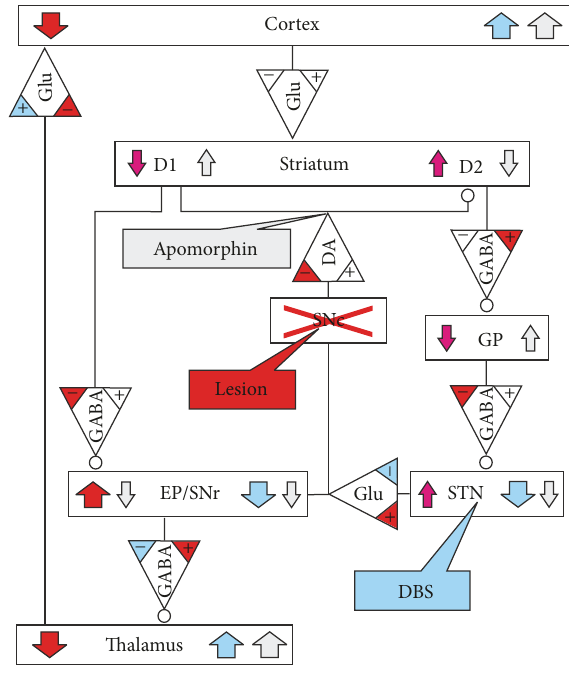
Figure 13: Simplified scheme of the lesioned hemisphere describing the effects of the lesion (red), DBS (blue), and apomorphine administration (light gray) on neurotransmitter release and on the activity (colored arrows) of different brain areas. Induced alterations in receptor numbers or sensitivities are not depicted; for explanation see Appendix. The brain areas are given in the boxes designated by SNc, GP, STN, and EP/SNr. The neurotransmitters glutamate (Glu), DA, and GABA are designated by triangular boxes pointing toward the affected brain areas that may be either excited (direct line input) or downregulated (input with circle). D1 and D2 stand for the dopaminergic receptors in the striatum, which are excited or inhibited by DA or apomorphine, respectively. Rectangular text bal- loons mark the input sites of lesioning, DBS, and apomorphine. The colored“+”and“ − “signsintheneurotransmittertrianglesdesignate the effects of lesioning (red) and DBS (blue) on transmitter release. Color-coding was not attempted for the effects of apomorphine on transmitter